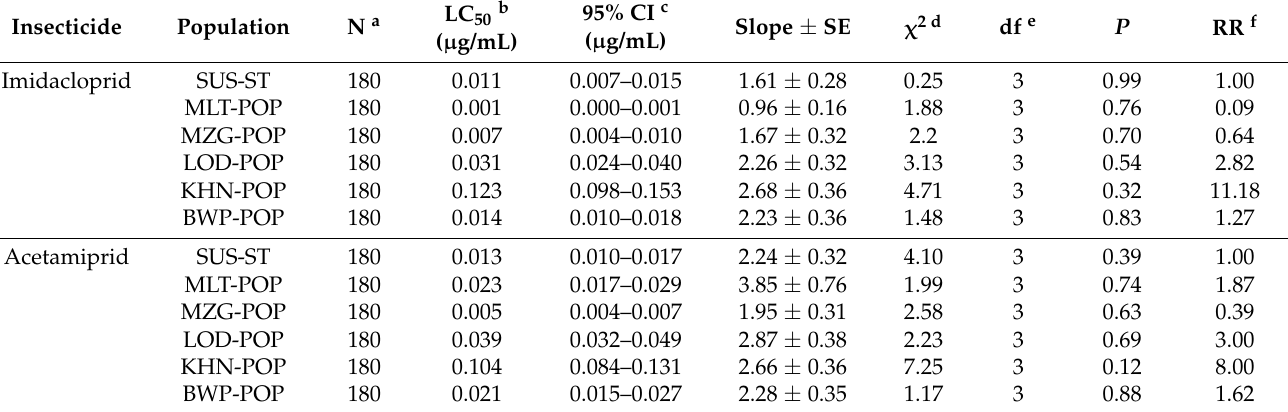
Table 2. Resistance levels of Culex quinquefasciatus to imidacloprid and acetamiprid.